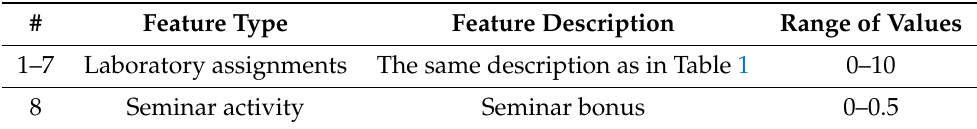
Table 2. Feature descriptions for the 2020-2021 academic